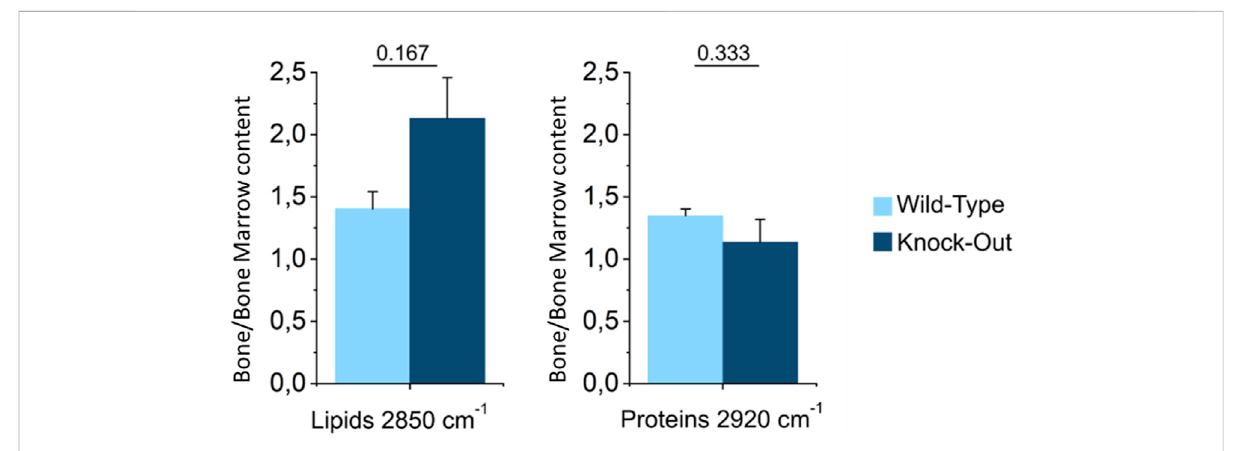
FIGURE 7 Ratio between the average signal intensity in the bone and in the bone marrow for lipids and proteins in WT and KO models. Statistical analysis was performed using t test. p -values are indicated above each bar plot ( n = 3 for both